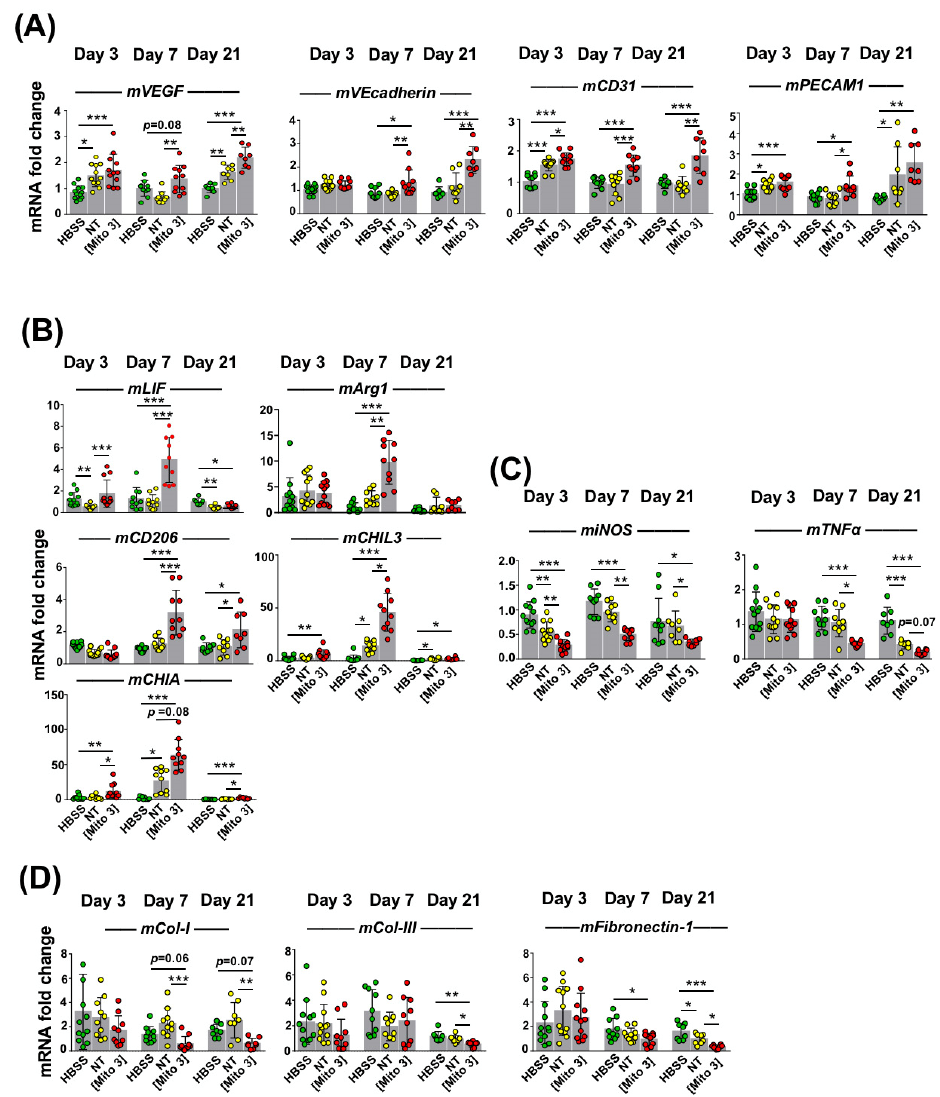
Figure 6. Cardiac mitochondria transfer improves the pro ‐ angiogenic, anti ‐ inflammatory and anti ‐ fibrotic effects of grafted MSCs. ( A – D ) MSCs were exposed to cardiac mitochondria at the Mito 3 concentration prior to engraftment in mouse hearts. Relative mouse mRNA expression of ( A ) VEGF , VEcadherin and CD31 ; ( B ) the anti ‐ inflammatory cytokine LIF or the anti ‐ inflammatory M2 macro ‐ phage markers ( Arg1 , CD206 , CHIL3 and CHIA ); ( C ) the pro ‐ inflammatory cell marker iNOS and the pro ‐ inflammatory cytokine TNF α ; and ( D ) the extracellular matrix components collagen ‐ 1 ( Col ‐ 1 ), collagen ‐ 3 ( Col ‐ 3) and fibronectin ‐ 1 in infarcted mouse hearts grafted with either human non ‐ treated or mitochondria ‐ preconditioned MSCs in reference to mouse infarcts injected with a saline solution (HBSS) at day 3 ( n = 12), day 7 ( n = 10), and day 21 ( n = 8) post ‐ surgery and graft. One ‐ way ANOVA with Tukey’s multiple comparisons test for mVEGF , mVEcadherin, mCD31 , miNOS , mTNF α and mFibronectin ‐ 1 . One ‐ way ANOVA with Dunn’s multiple comparisons tests were performed for the other genes. * p < 0.05, ** p < 0.01, *** p < 0.001. Each dot represents a mouse. Bar graphs represent mean values ± SD.